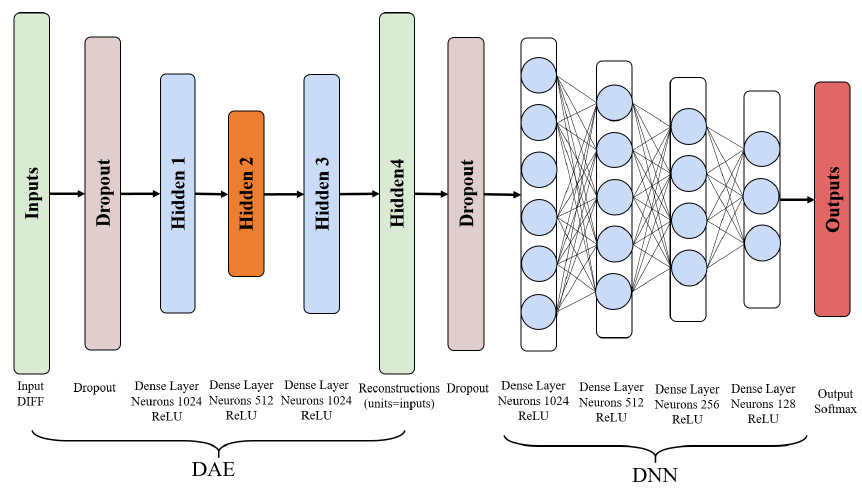
Figure 5. DDAE Location Estimation